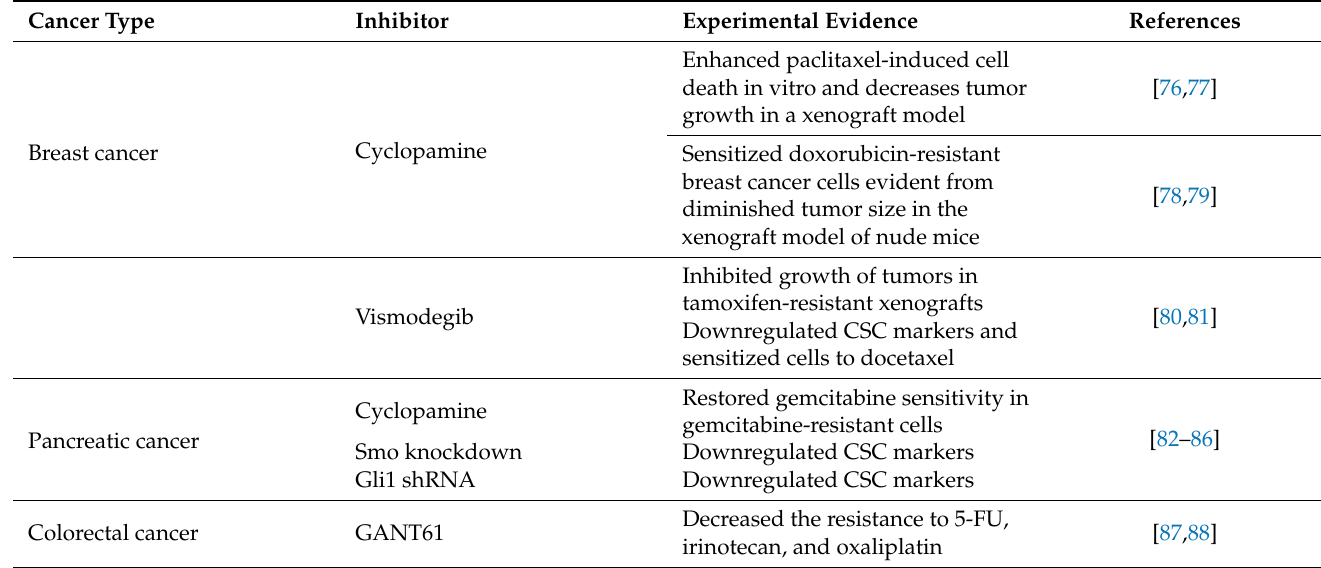
Table 3. Summary of evidence for the role of Hedgehog signaling in chemoresistance of cancer stem cells. Cancer